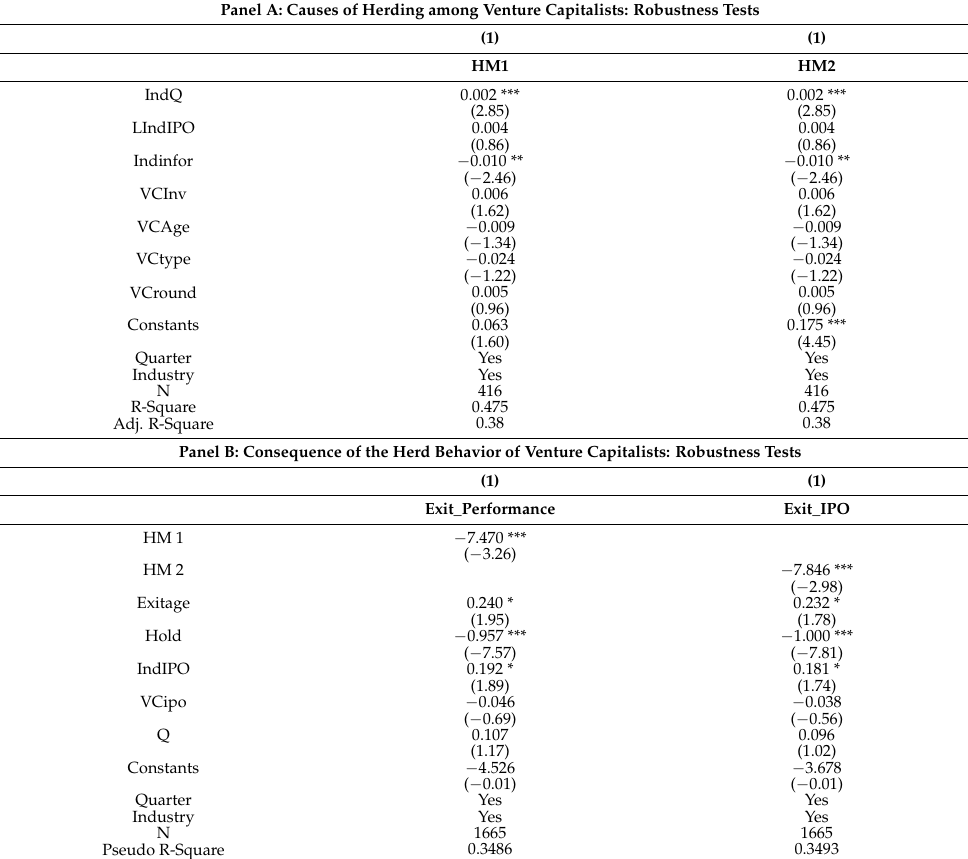
Table 8. Robustness tests: alternative herding measures. Panel A: Causes of Herding among Venture Capitalists: Robustness